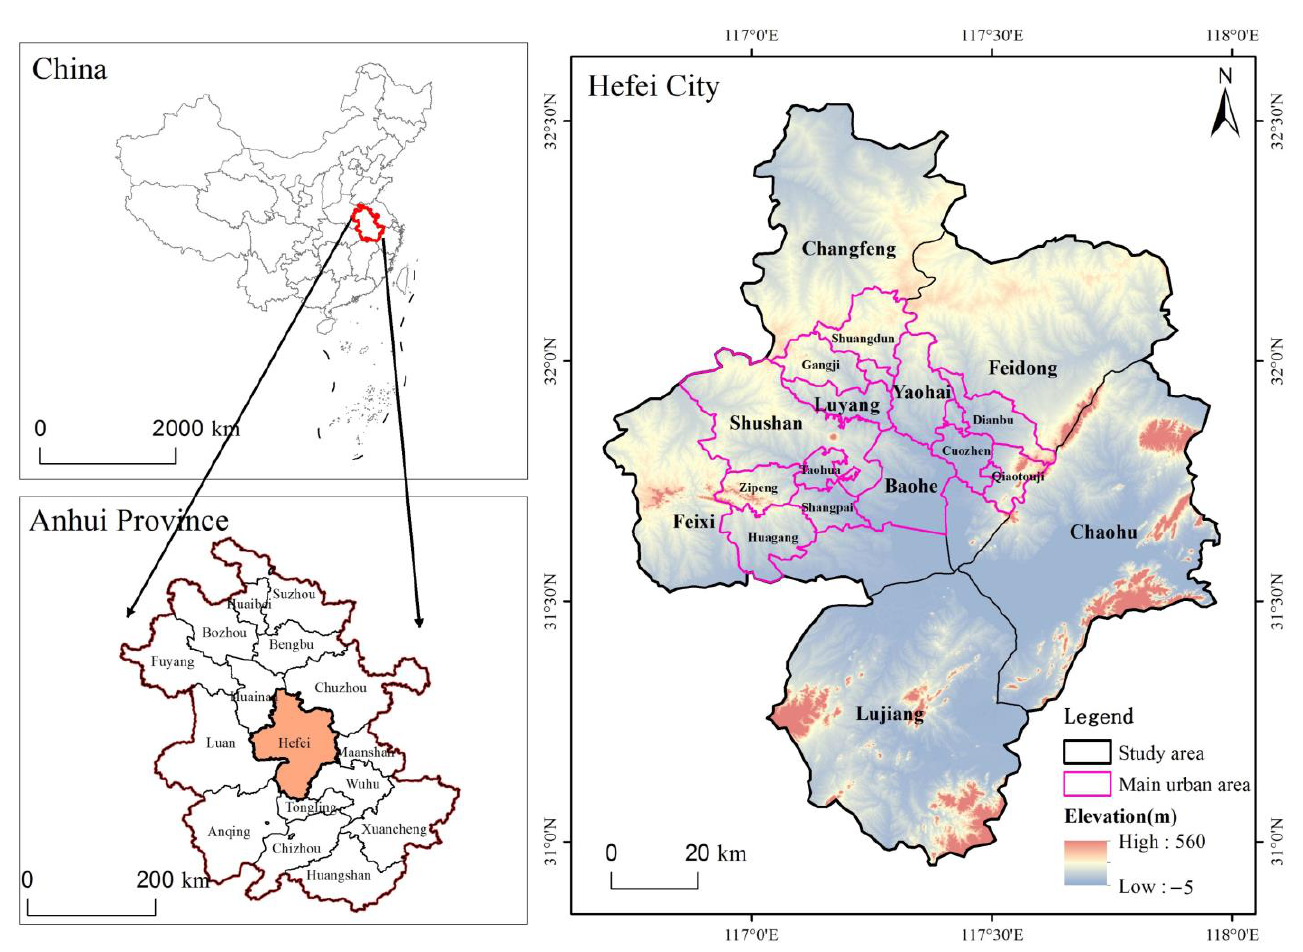
Figure 1. The spatial location of the study area.